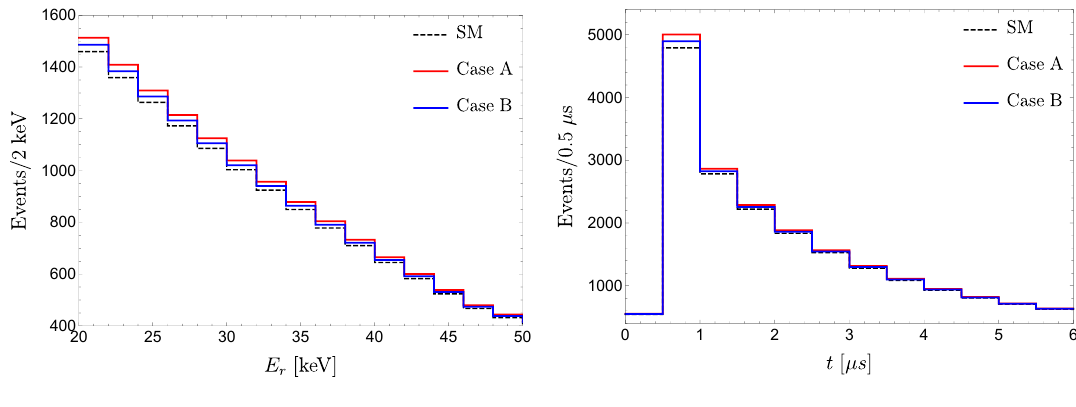
Figure 3. Recoil energy (left) and temporal (right) distributions in an upgraded COHERENT LAr detector with m det = 750 kg and 4 years of data. The black dashed histograms correspond to the SM case, the red (blue) lines correspond to Case A (B) with M Z 0 = 10 GeV and g 0 = 0 : 002. with our benchmark point, are the regions between the red curves in (cid:12)gure 4. The 2 (cid:27) regions for Case B are too large to